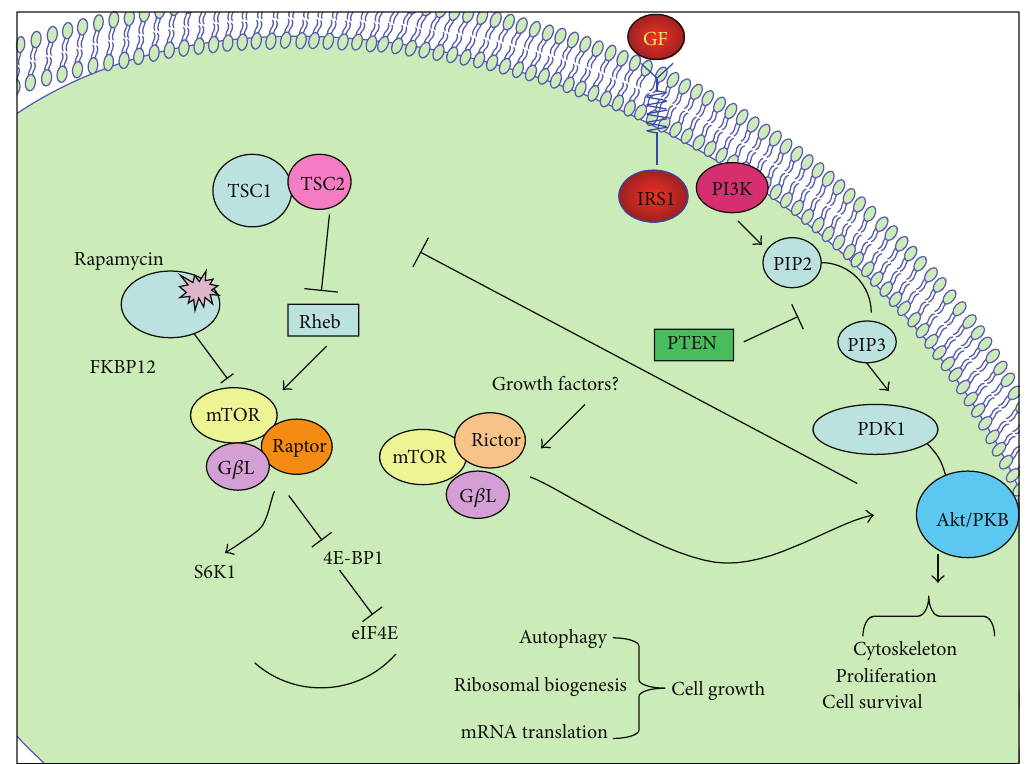
Figure 1: Schematic representation of the PI3K/Akt/mTOR pathway substrates and associated cellular functions. The tumor suppressor protein/lipid PTEN negatively regulates AKT. Following activation, Akt translocates into the cytoplasm and nucleus and phosphorylates TSC2. mTORC1 (mTOR + raptor) and mTORC2 (mTOR + rictor) are two distinct branches of the mTOR pathway. mTORC1 responds to nutrients and growth factors and is regulated by TSC1/2 and Rheb, whereas it is unknown how the mTORC2 complex is regulated. The raptor-mTOR pathway regulates cell growth while rictor-mTOR regulates Akt/PKB to control cell survival, proliferation, and